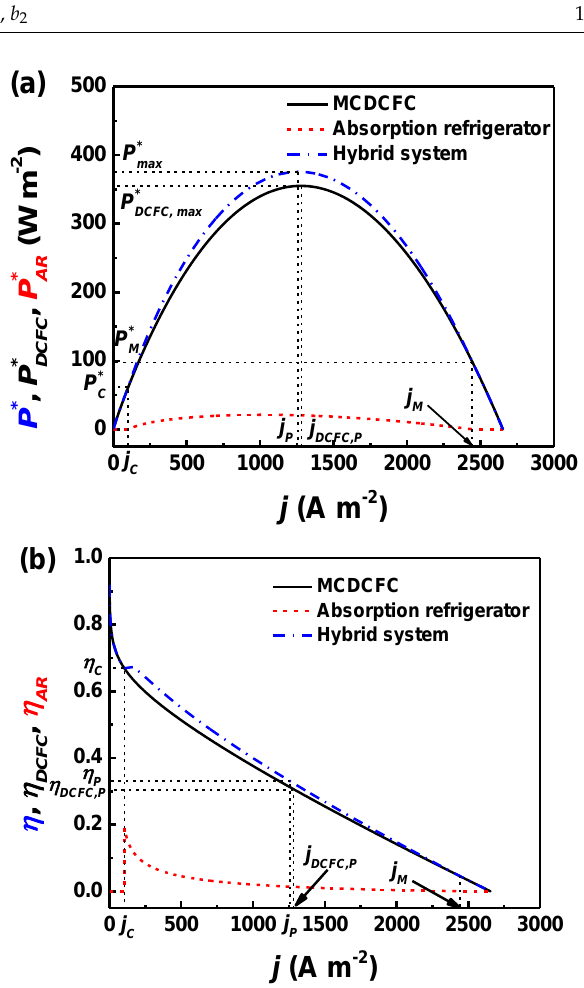
Figure 2. Curves of ( a ) power densities and ( b ) efficiencies of the MCDCFC, absorption refrigerator, and hybrid system varying with the operating current density of the MCDCFC. Table 1. Parameters used in the modeling [10,34,36,44].